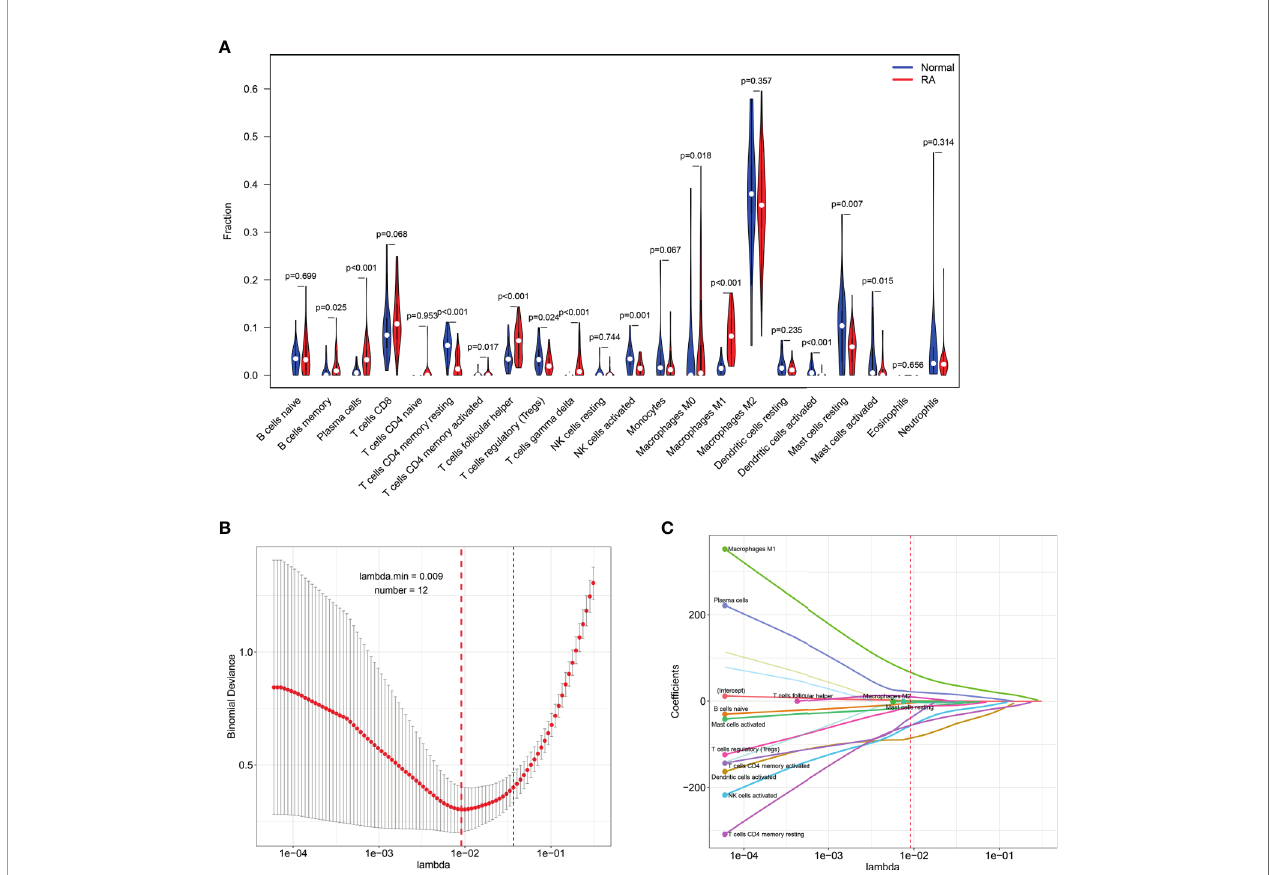
FIGURE 3 | Identifying the signi fi cantly different in fi ltrates of immune cells in RA. (A) Wilcoxon test and (B, C) LASSO regression were conducted to analyze the different in fi ltrates of immune cells in RA and